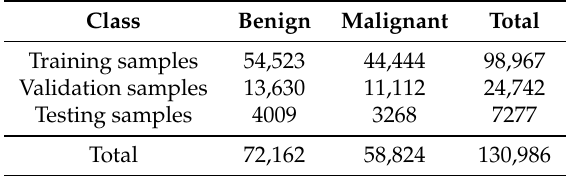
Table 2. CBIS-DDSM dataset distribution after the four augmentation methods combined.